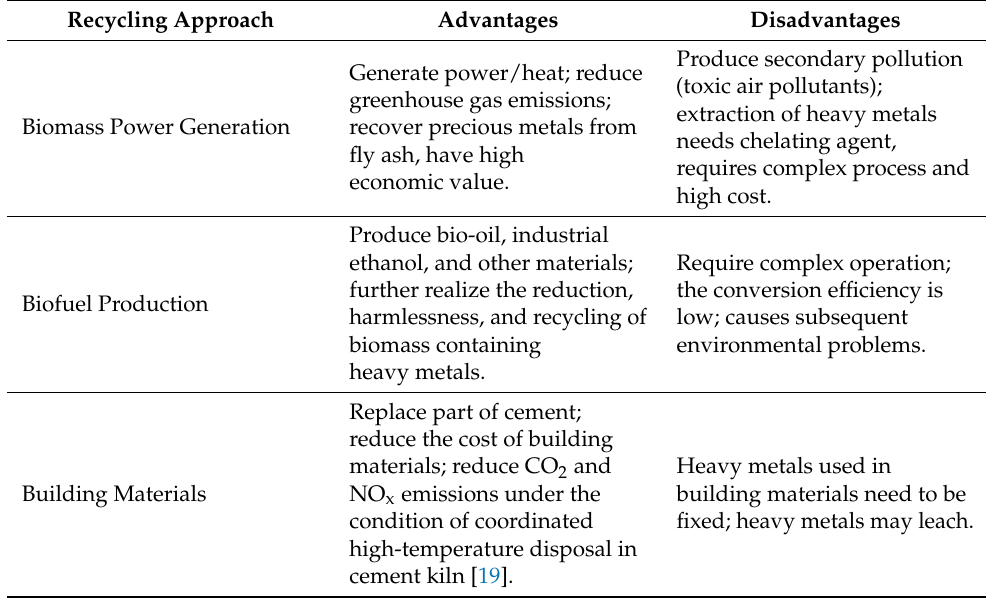
Table 1. Recycling pathways and advantages and disadvantages of plants containing heavy